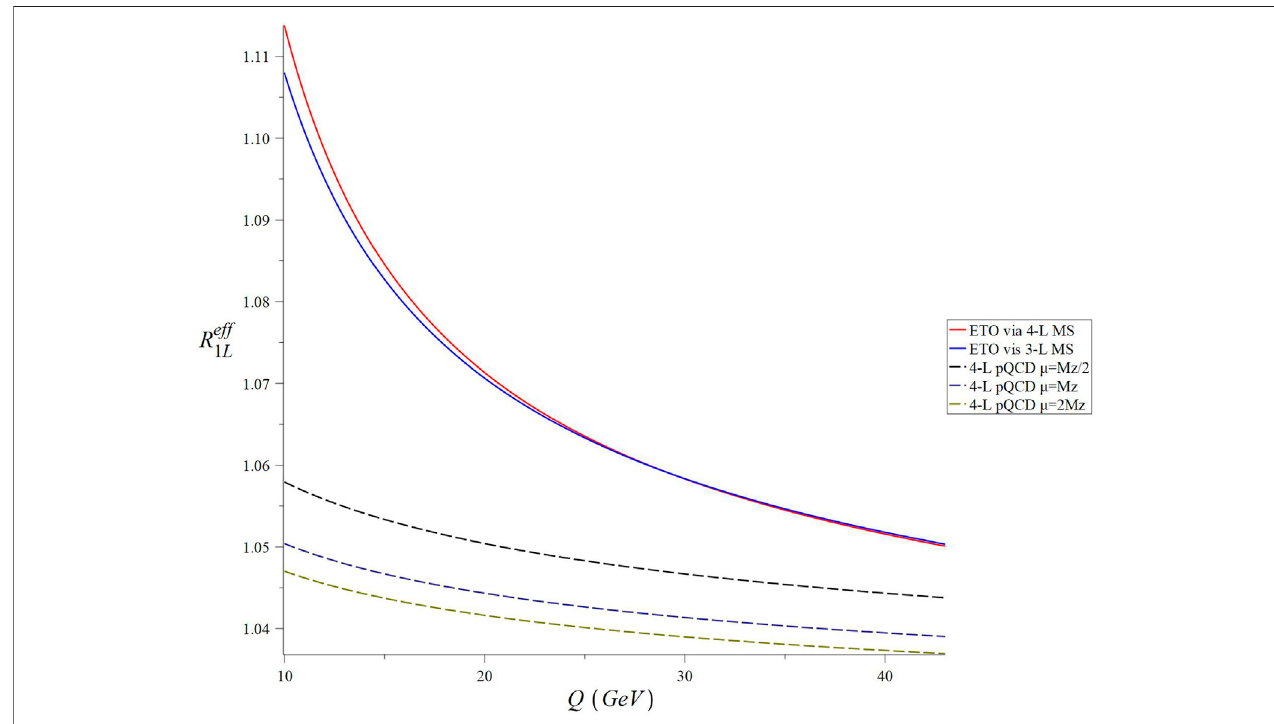
FIGURE 1 | Q dependence of RSS-independent R eff at one loop matched with three- and four-loop MS and compared to four-loop perturbative QCD in the MS scheme for R e + e − referenced at renormalization scales, μ (cid:2) M Z /2, μ (cid:2) M Z , and μ (cid:2) 2 M Z